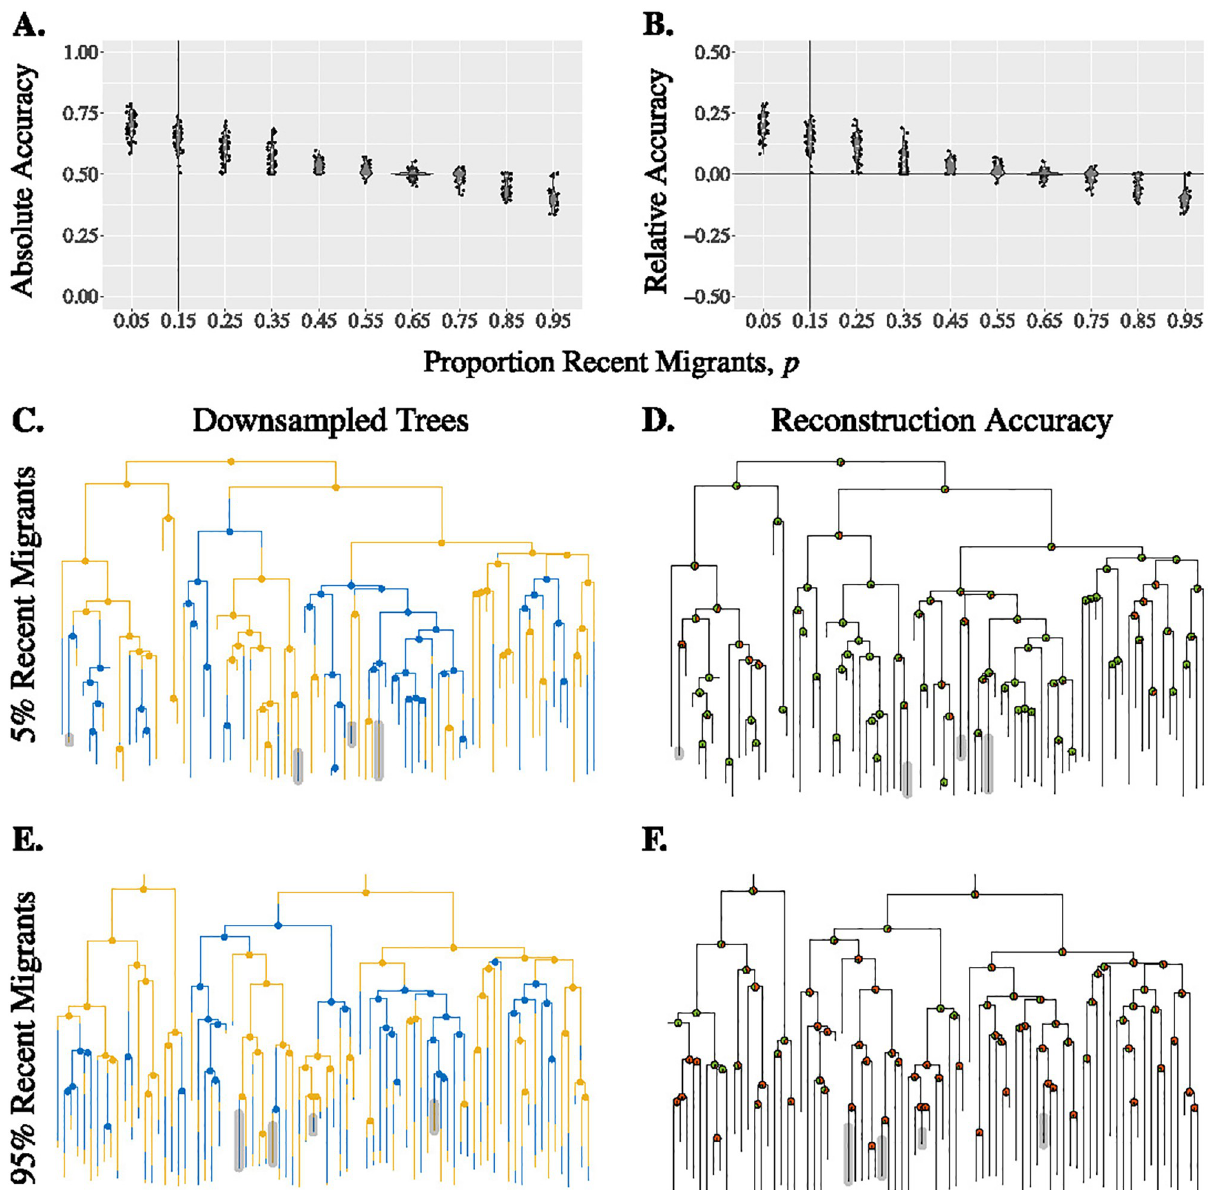
Fig 2. Reconstruction accuracy depends on the sampling of recent migrants. Absolute (Panel A) and relative (Panel B) accuracy of downsampled trees with varying p . The corresponding true tree is shown in Fig 1C with the vertical line showing the proportion of recent migrants in this true tree. Panels C & E: Examples of downsampled trees from the true tree in Fig 1C with a low (Panel C: p = 0.05; recent migrants highlighted) or high (Panel E: p = 0.95; non-migrants highlighted) proportion of recent migrants tips. Panels D & F: The absolute accuracy of each internal node (green fraction) of the downsampled trees in panels C and E respectively. Parameters: λ = 4, μ = 1, α = 0.9, and k = 0.5.